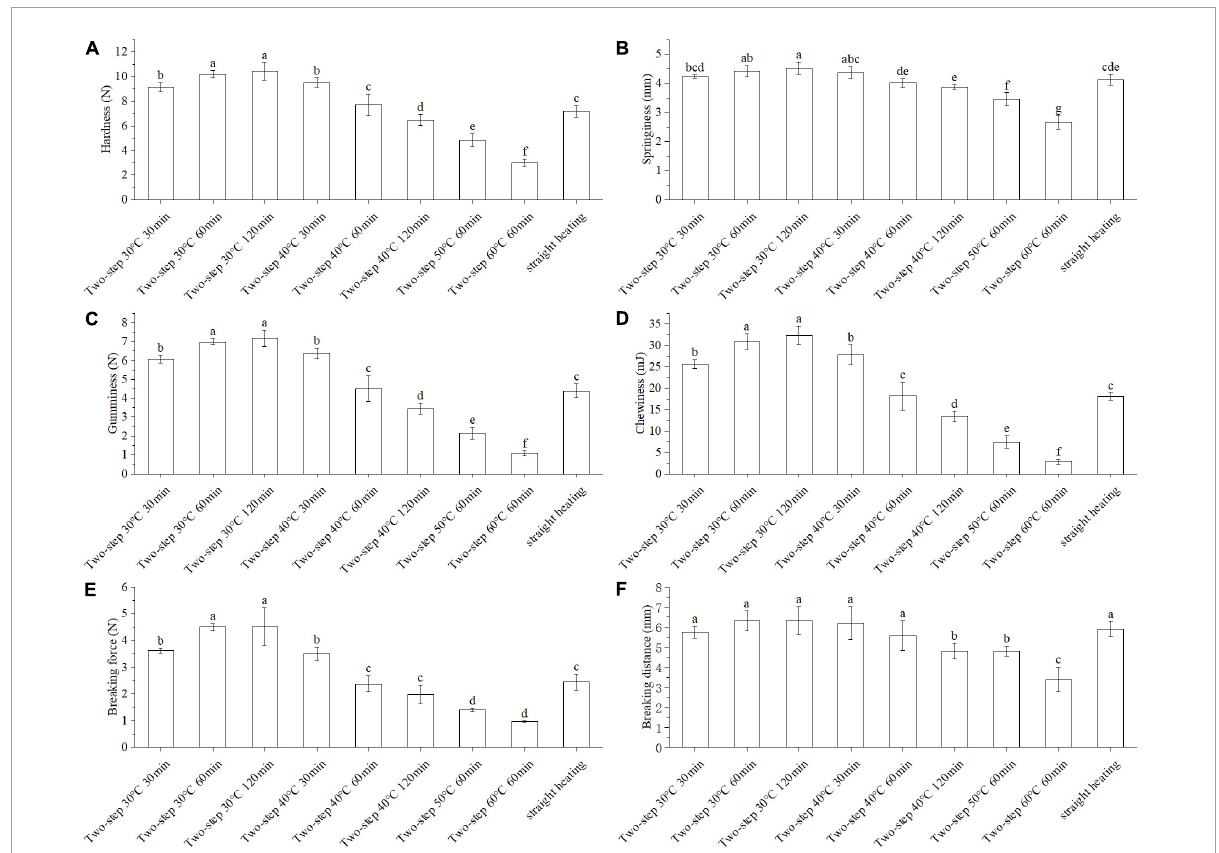
FIGURE1 Changes of texture and gel strength under different heating conditions. Different letters showed the significant changes ( p < 0.05). (A) Hardness, (B) springiness, (C) gumminess, (D) chewiness, (E) breaking force, and (F) breaking distance. Data were obtained as the mean ± standard deviation ( n =